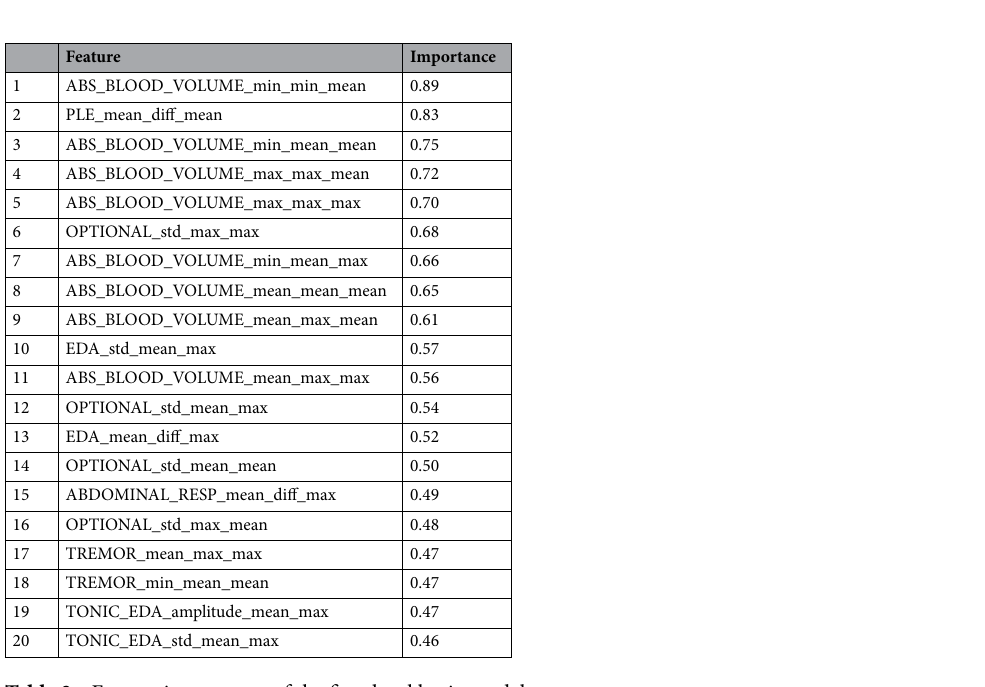
Table 2. Feature importance of the first-level basic